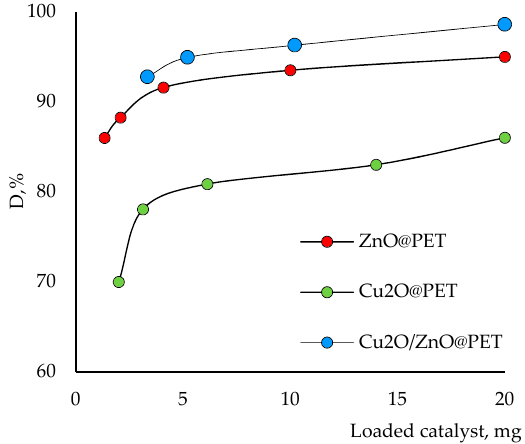
Figure 9. Effects of the catalyst amount on the degradation efficiency of Czm (1.0 mg/L, time 160 min and pH 6.0).